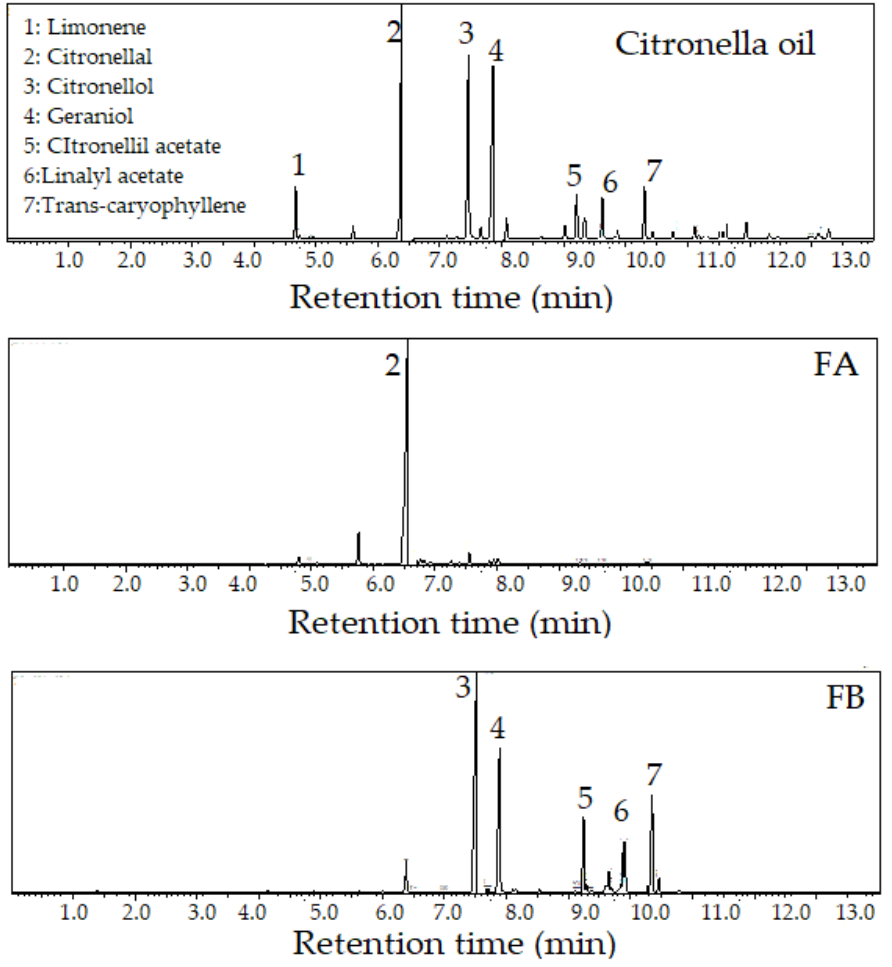
Figure 2. Chromatograms of Citronella Oil, FA and FB.